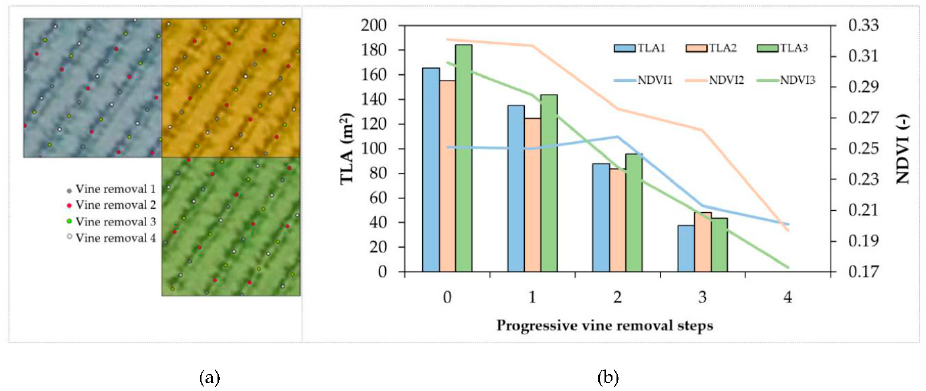
Figure 5. ( a ) Detail of the vine removal by phase. ( b ) TLA (m 2 ) and NDVI values in each pixel.